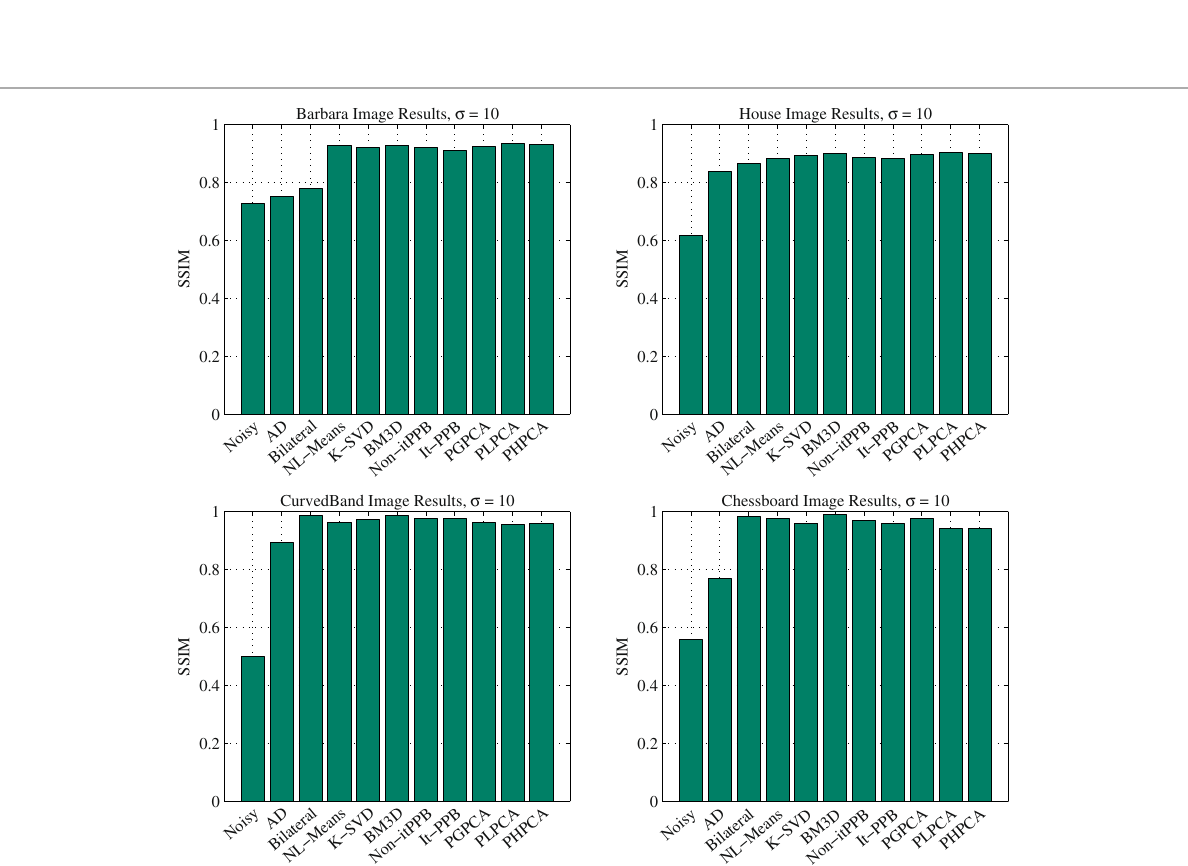
Fig. 12 The performance charts: four charts summarize the performance of the denoising methods for the four images when the noise is low (σ = 10